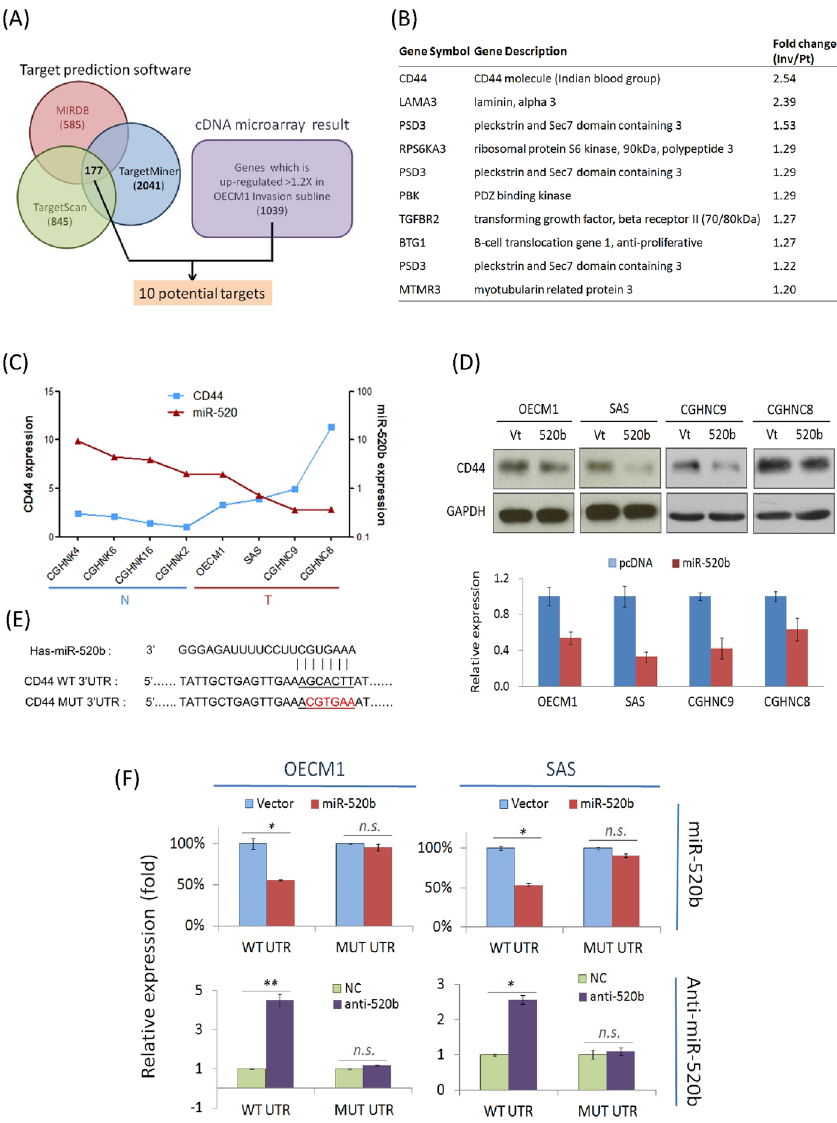
Figure 5. CD44 is a direct regulatory target of miR-520b. ( A ) Bioinformatics-based prediction of the regulatory targets of miR-520b using MIRDB, TargetScan, and TargetMiner computational prediction software. ( B ) List of 10 potential target genes, after integrative analysis of bioinformatic prediction results and the microarray dataset from a highly invasive cell subline. ( C ) The inverse correlation between CD44 and miR-520b expression. Total of 4 lines of normal keratinocytes (CGHNK4, CGHNK6, CGHNK16, CGHNK2) and 4 lines of HNC cells (OECK1, SAS, CGHNC9, CGHNC8) were used. The expression levels of miR-520b were determined by RT-qPCR based assays after normalization to the level of U6 RNA (internal control) for each sample. The CD44 levels were determined by RT-qPCR assays after normalization to GAPDH (internal control) for each sample. ( D ) The effect of miR-520b on CD44 protein expression. After transfection of HNC cells (OECM1, SAS CGHNC8, CGHMC9) with miR-520b over-expression plasmids for 24 hrs, the cellular proteins were extracted and subjected to western blot analysis to determine the CD44 expression. The relative expression was determined after normalization to GAPDH, which was used as an internal control. ( E ) The sequences and binding sites of miR-520b and its target gene, CD44. The mature sequences of miR-520b, as well as the 3 ′ -UTR sequence of the human CD44 gene are shown. The mutant sequence of the 3 ′ -UTR region of CD44 was then designed. ( F ) A luciferase reporter assay was used to determine whether CD44 is a direct target of miR-520b. Cells transfected with miR-520b over-expression plasmids or anti-miR-520b antigomirs were co-transfected with p-WT-UTR or p-MUT-UTR, as indicated in each specific bar of the figure. Renilla luciferase was also co- transfected as a reference control for each condition. Firefly and Renilla luciferase activities were measured by a dual-luciferase reporter assay as described in the Method section. All the experiments were performed duplicate for three times, and the similar results were obtained. The error bars shown in the relevant figures indicated the standard deviation of the three independent experiments. ( * p < 0.05, ** p < 0.01, n.s.: non-significance,